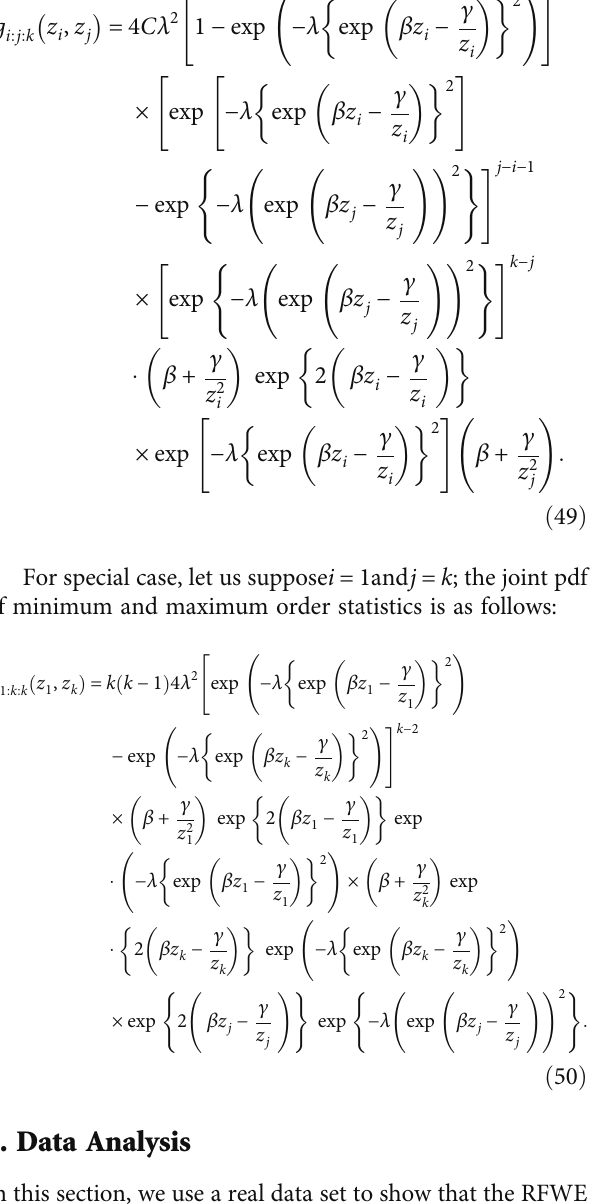
Table 1: Goodness of fi t results using AD, CM, and KS.